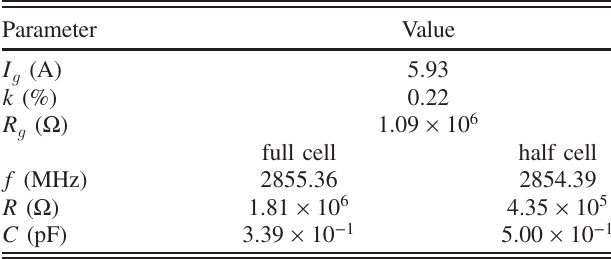
TABLE I. Parameters of the circuit model. Parameter